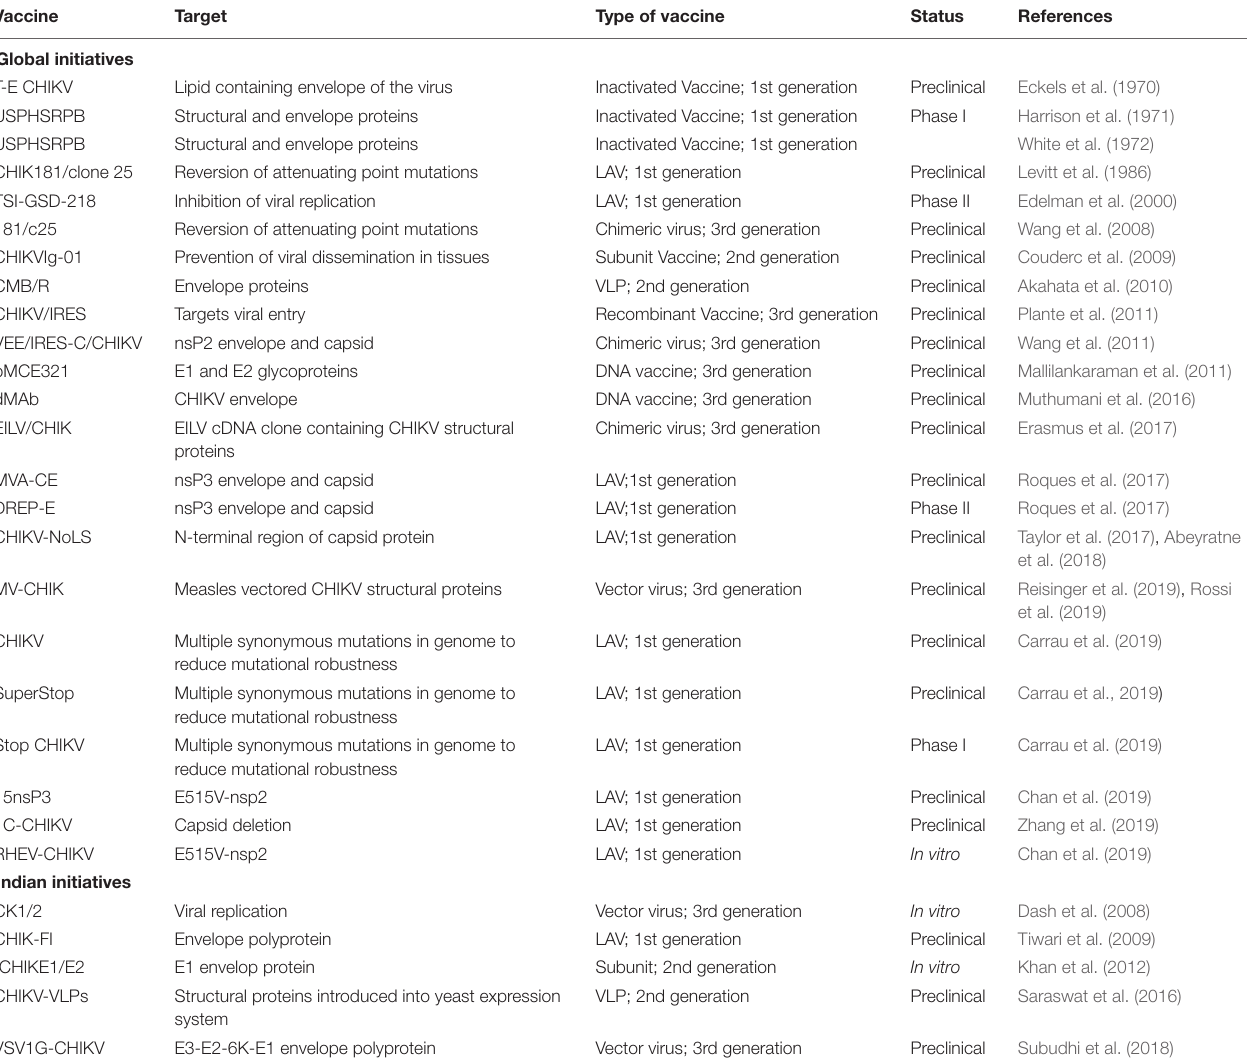
TABLE 3 | List of possible CHIKV vaccine